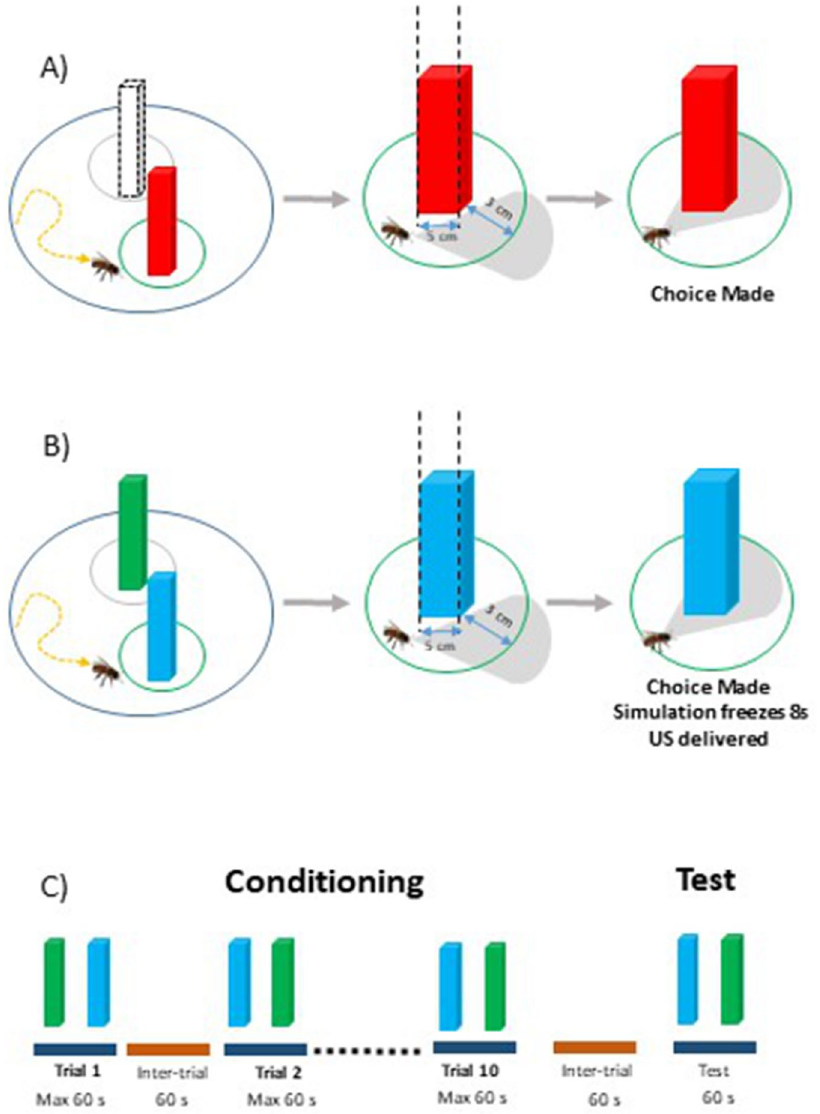
Figure 2. Choice and discrimination learning tasks in the VR setup. ( A ) Experiment 1: Quantification of the spontaneous phototactic responses of bees towards a red cuboid against the absence of an equivalent stimulus in the symmetric position (dashed cuboid). Choice of the red cuboid was recorded if the bee reached a virtual area of a radius of 3 cm centered on the cuboid and fixed it frontally. ( B ) Experiments 2 and 3: Color discrimination learning with a green and a blue cuboid. One cuboid was rewarded with sucrose solution and the other punished with either quinine solution (Experiment 2) or saline solution (Experiment 3) delivered by the experimenter. A choice was recorded when the bee reached an area of a radius of 3 cm centered on the cuboid and fixed it frontally. The cuboid image was then frozen during 8 s and the corresponding reinforcement (US) was delivered. ( C ) Experimental schedule of color learning experiments (Experiments 2 and 3). Bees were trained along 10 conditioning trials that lasted a maximum of 1 min and that were spaced by 1 min (intertrial interval). After the end of conditioning, and following an additional interval of 1 min, bees were tested in extinction conditions with the two colored cuboids during 1